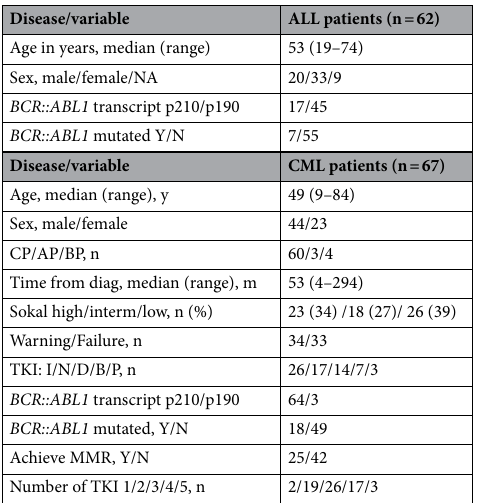
Table 1. Summary of the main data of the two cohorts. AP accelerated phase, ALL acute lymphoblastic leukemia, BP blast phase, B bosutinib, CML chronic myeloid leukemia, CP chronic phase, D dasatinib, diag diagnosis, I imatinib, MMR major molecular response, NA non-available data, N nilotinib, P ponatinib, TKI tyrosin-kinase